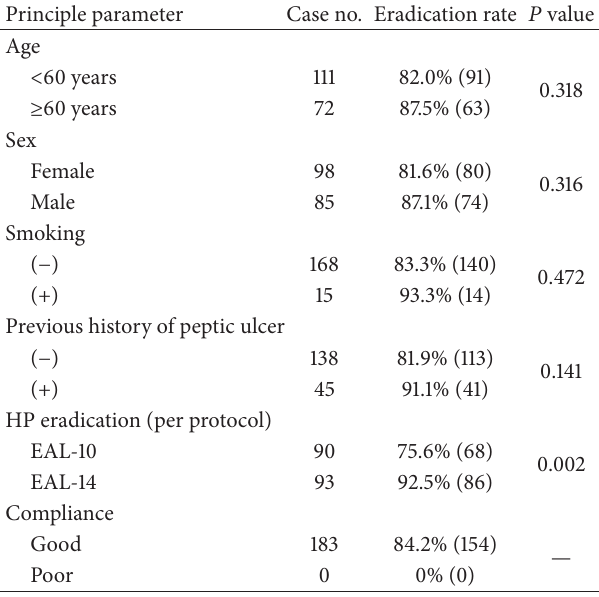
Table 4: Univariate analysis of the clinical factors influencing the efficacy of Helicobacter pylori